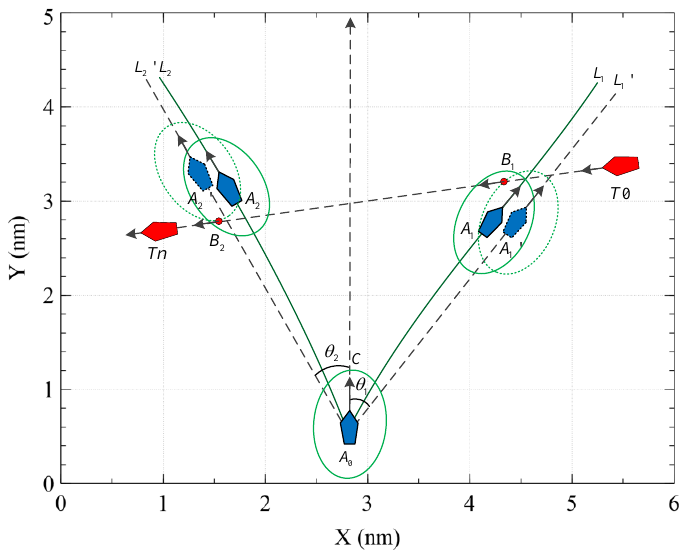
Figure 3. Dynamic feasible manoeuvring range.